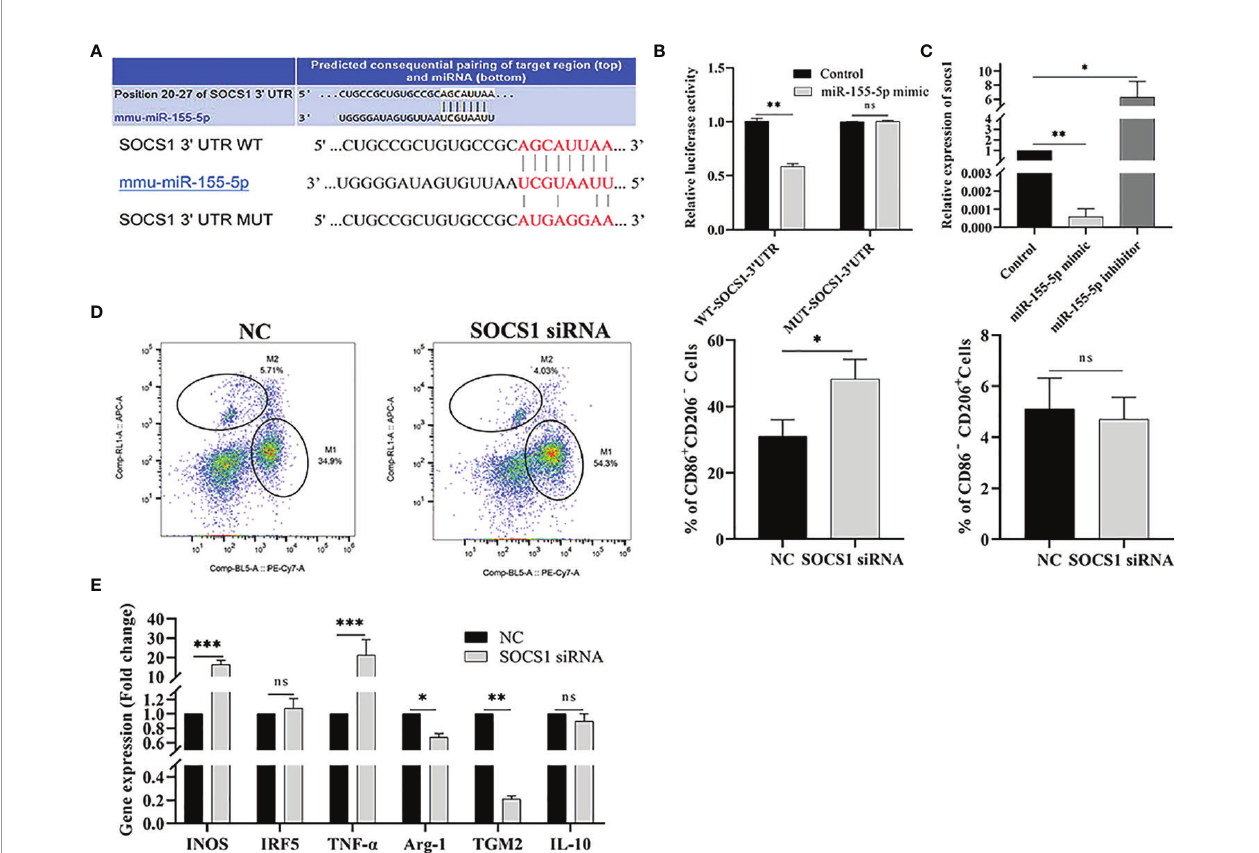
FIGURE 7 | miR-155-5p regulates Raw264.7 cell polarization by targeting SOCS1. (A) Binding sequence between miR-155-5p and SOCS1 predicted by bioinformatics online analysis tool TargetScan. (B) The luciferase activity of HEK293 cells co-transfected with miR-155-5p mimics and luciferase reporter vectors containing wild type and mutant SOCS1 3 ‘ UTR. (C) miR-155-5p mimics and inhibitors were transfected into Raw 264.7 cells, and SOCS1 expression in Raw264.7 cells was determined by qRT-PCR. (D) The proportion of CD86 + CD206 − M1 and CD86 − CD206 + M2 macrophages in Raw264.7 cells detected by fl ow cytometry after transfection with SOCS1-speci fi c siRNA. (E) The mRNA levels of characteristic genes of M1 (INOS, TNF- a and IRF5) and M2 (TGM2, IL-10 and Arg-1) macrophages in Raw264.7 cells treated with SOCS1-siRNA were detected by qRT-PCR. ns (p ≥ 0.05), *p < 0.05, **p < 0.01, ***p <